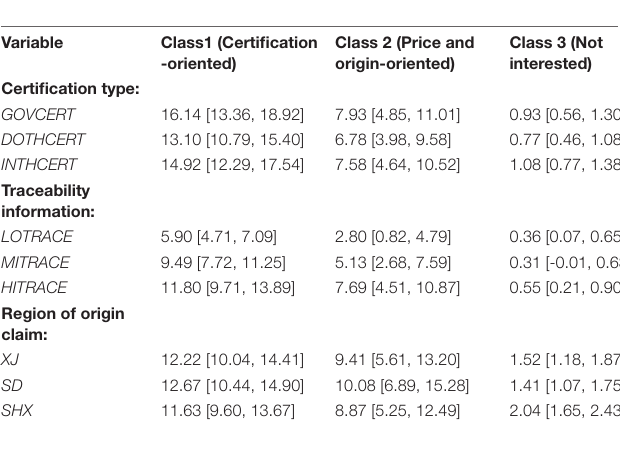
TABLE 5 | Marginal WTP estimates for each latent